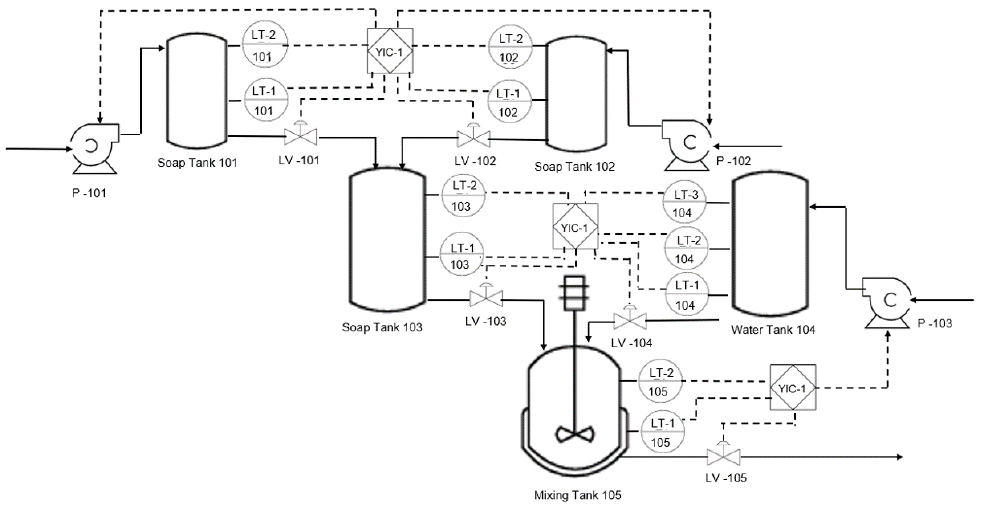
Figure 9. P&ID of a tank filling process (Plant for the tank filling process example).